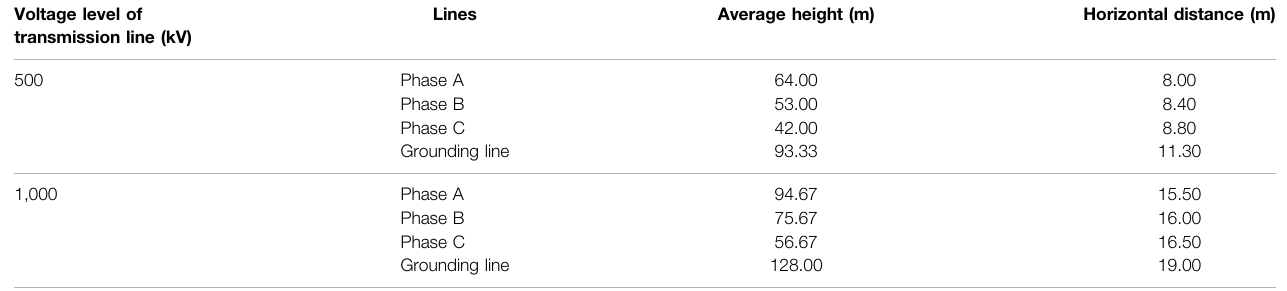
TABLE 1 | Size parameters of double-circuit AC transmission lines on the same tower in Japan. Voltage level of transmission line (kV)